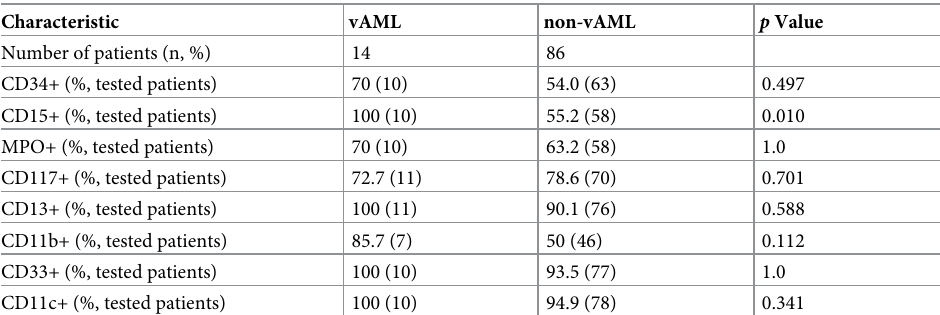
Table 2. Immunophenotypic analysis of the bone marrow.